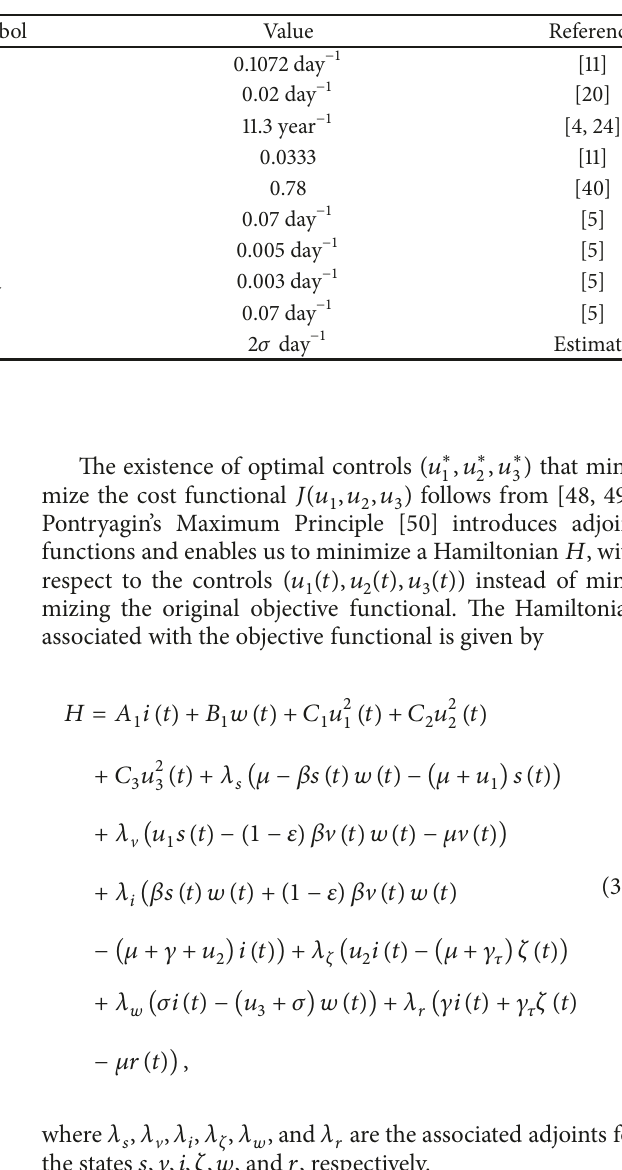
Table 1: Parameter values used for numerical simulations with